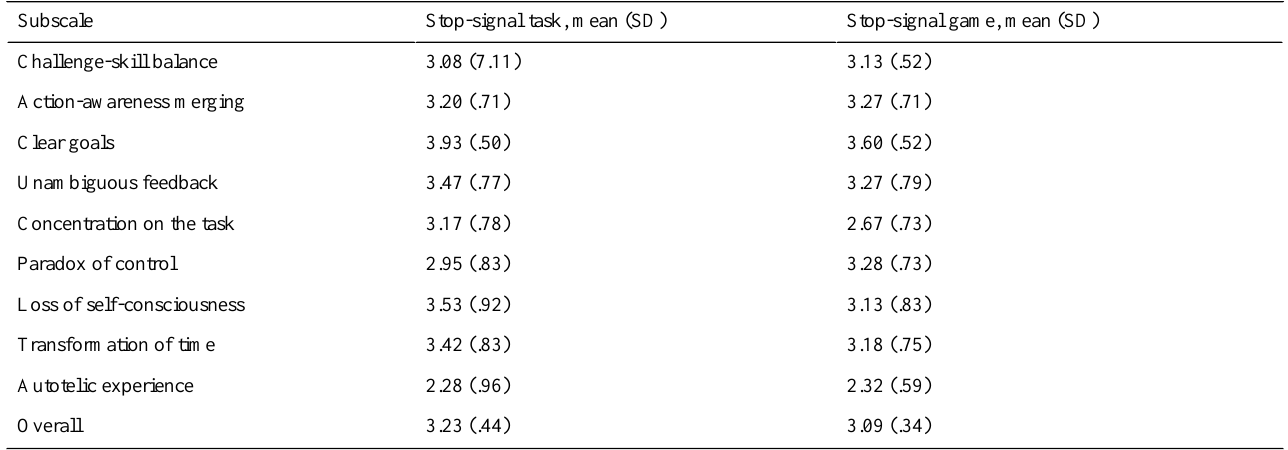
Table 9. Mean scale values for each Flow subscale depending on task variant and the study (study